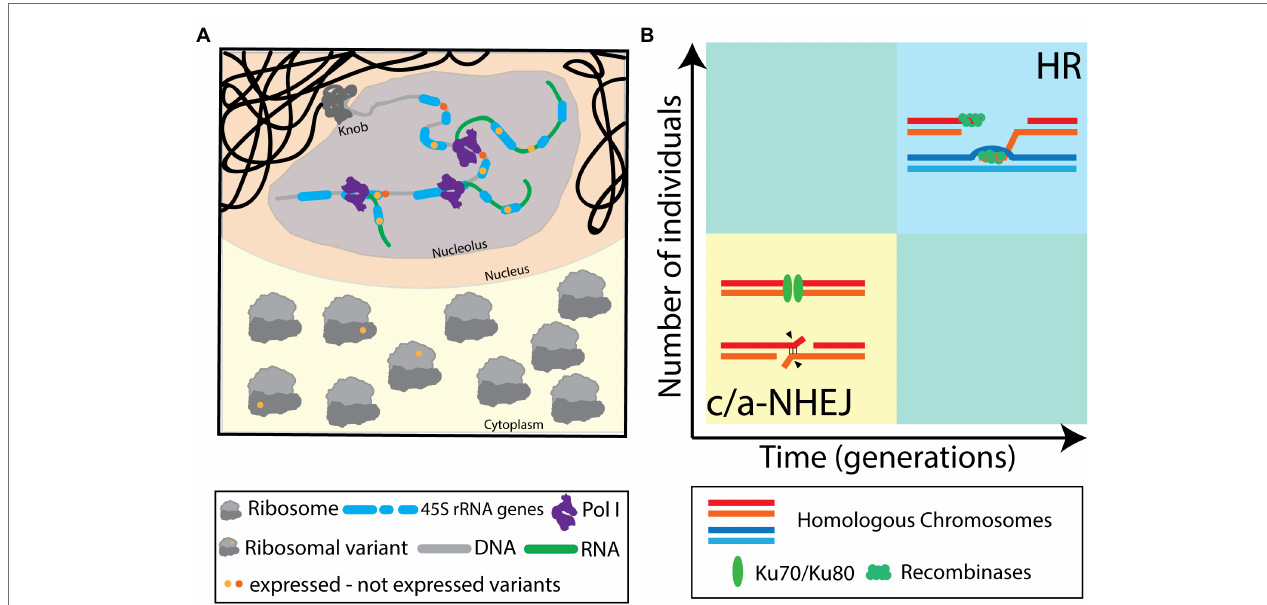
FIGURE 2 | (A) Illustration of transcription of variant rRNAs from non-identical 45 rDNA units and their integration into translating ribosomes. The concept of heterogeneous ribosomes has been introduced considering different protein compositions. Here, this concept is extended, also considering different rRNA variants. (B) Diagram illustrating the occurrence of non-homologous end joining (NHEJ) and homologous recombination (HR) as DNA repair modes in the highly repetitive nucleolus organizing regions (NORs) during meiosis. NHEJ is considered to be the commonly deployed repair pathway, leading to short-range repair scars in the affected rDNA units, contributing to sequence heterogeneity and preserving the integrity of the NOR. Meiotic DNA repair events via HR are considered rare events and will only be evident in large populations, over multiple generations. HR may contribute to NOR size variability and rDNA unit